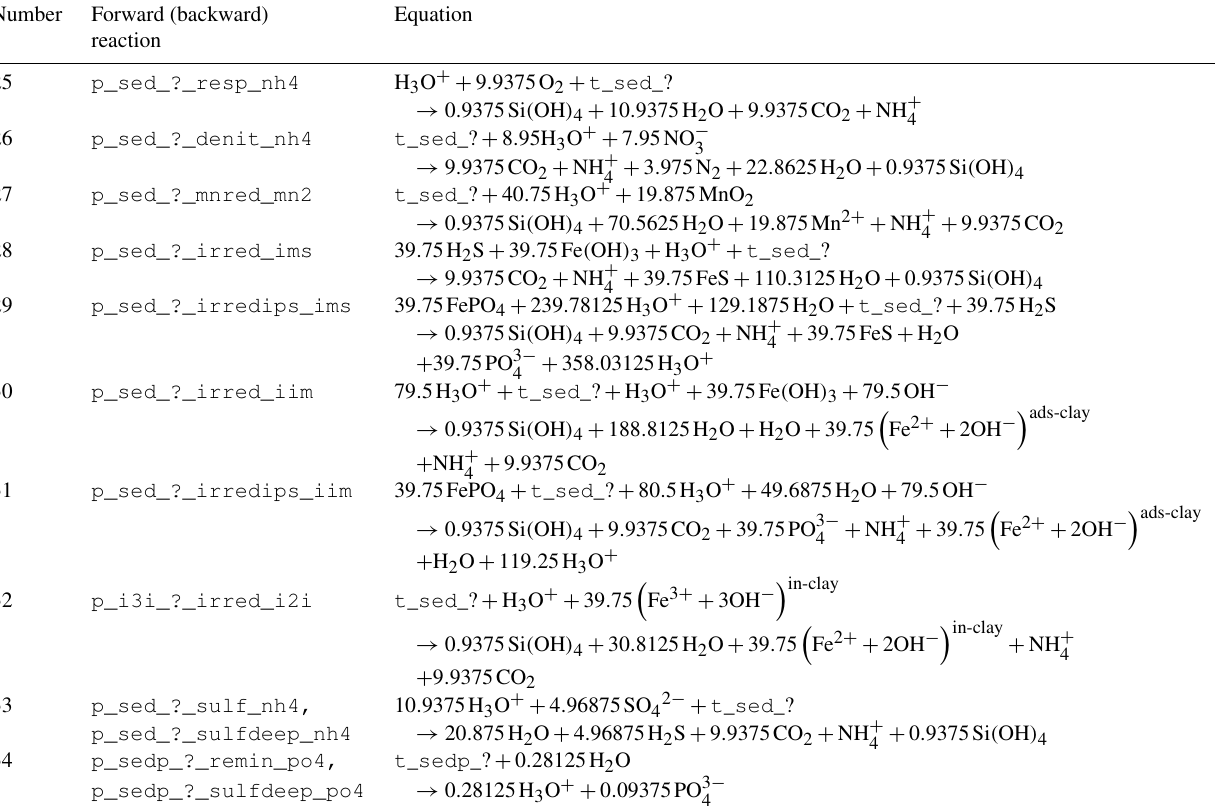
Table 3. Reaction network table for the primary redox reactions in the sediment and the fluff layer. See Table A1 for the composition of state variables.